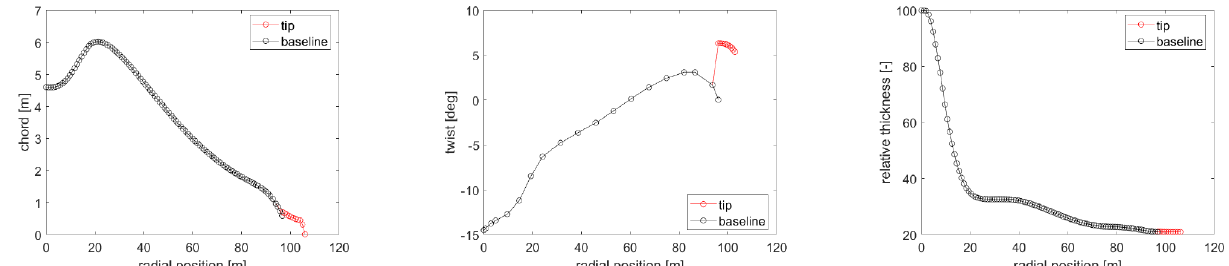
Figure 10. Planform of the optimized